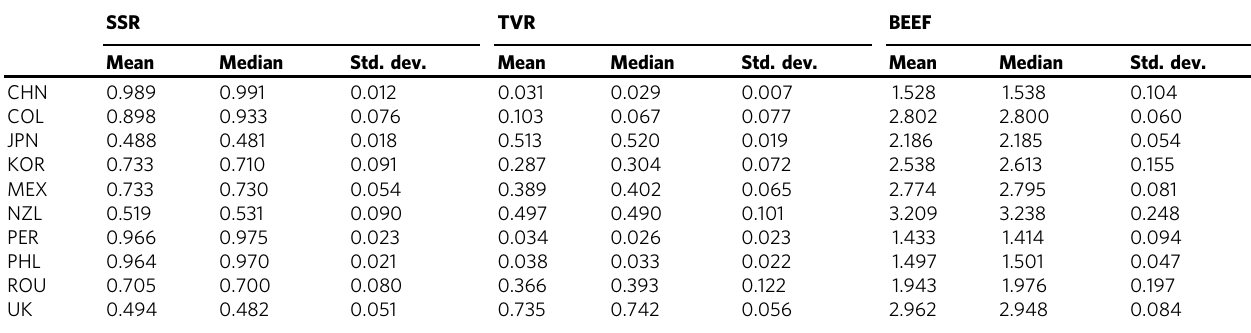
Table 3 De fi nitions of the variables in the panel analysis. Variable De fi nition DCC i,t Dynamic conditional correlation of pork between global and country i ’ s local price at time t . Self-suf fi ciency rate of pork in country i at time t . Trade volume rate of pork in country i at time t . Domestic consumption of beef in country i at time t .